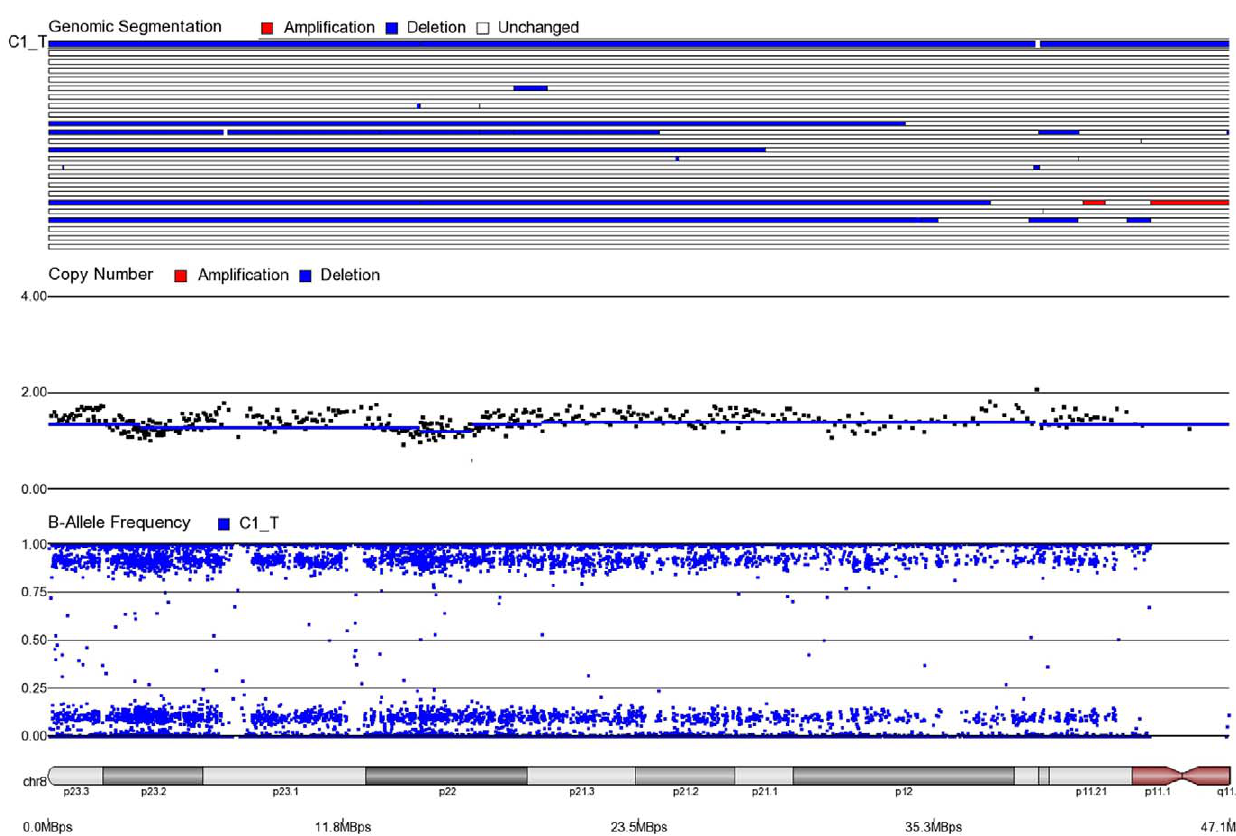
Figure 4. Mosaic monoallelic deletion in chromosome 8p for CRC tissue sample C1_T. BAF=0.17, 0.83 and CN=1.2. Approximately 80% cells have mono-allelic deletion (A_ or B_).